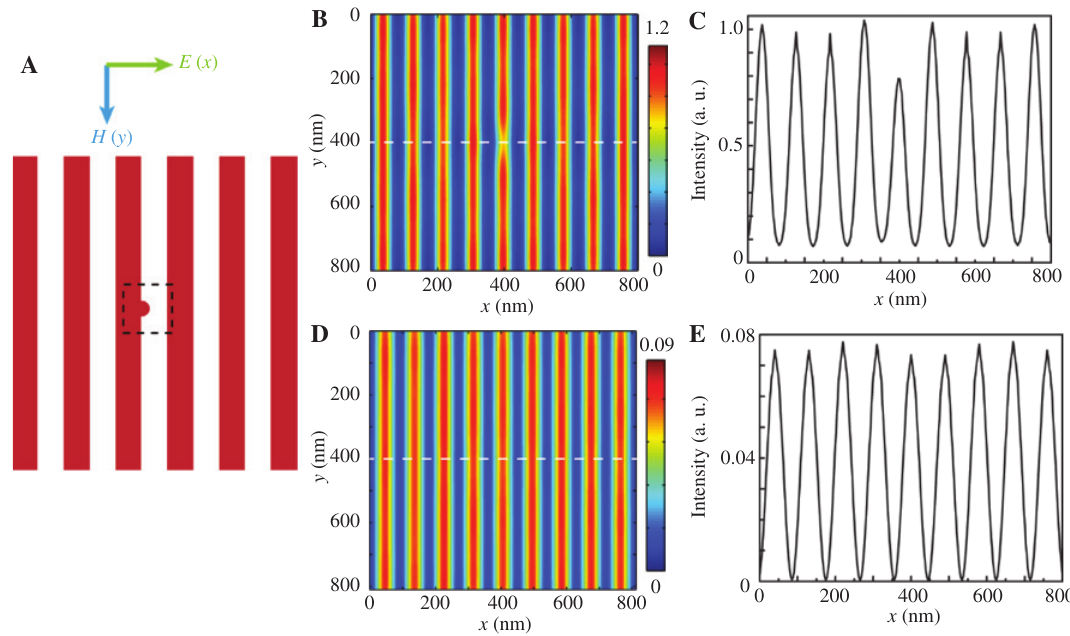
Figure 5: Impacts of isolated defects in both superlens and HMM systems. (A) Schematic of the defective grating mask. (B, D) Normalized electric field intensity distributions extracted from the middle position of the PR film in superlens and HMM lithography systems, respectively. (C, E) Corresponding intensity distributions at the dashed line positions in (B) and